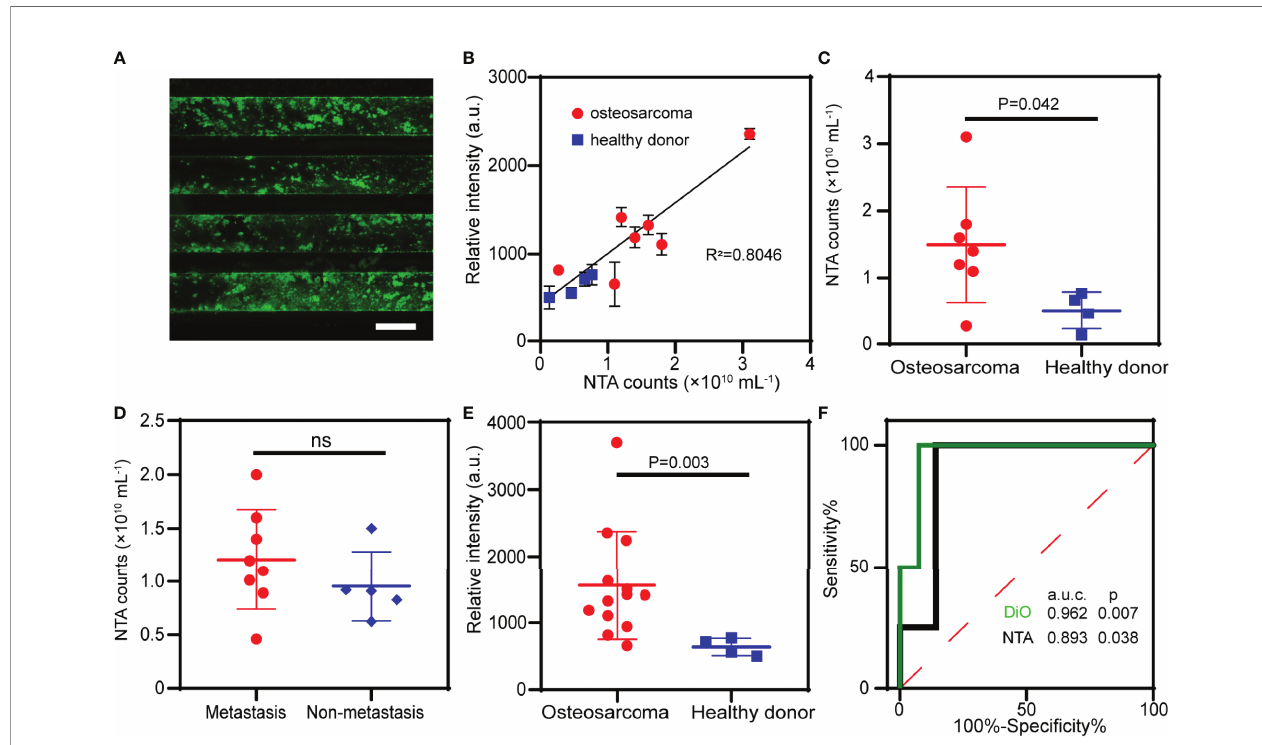
FIGURE 4 | Clinical validation of the ZNI chip in patients of osteosarcoma (OS). (A) Fluorescence image of EVs from plasma captured by ZNI chip. Scale bar: 200 m m. (B) Correlation analysis of NTA and ZNI chip fl uorescence quanti fi cation of plasma EVs in 7 OS patients and 4 healthy donors. (C) NTA of the plasma EVs from OS patients and healthy donors. (D) NTA of the plasma EVs from OS patients with metastasis and without metastasis. (E) Fluorescent quantitation of plasma EVs from OS patients and healthy donors. (F) Receiver operating characteristic (ROC) analysis of plasma EVs quanti fi ed by ZNI chip and NTA between OS patients and healthy donors. The statistical difference of the two groups was compared using the Mann-Whitney U test. ns, non-signi fi